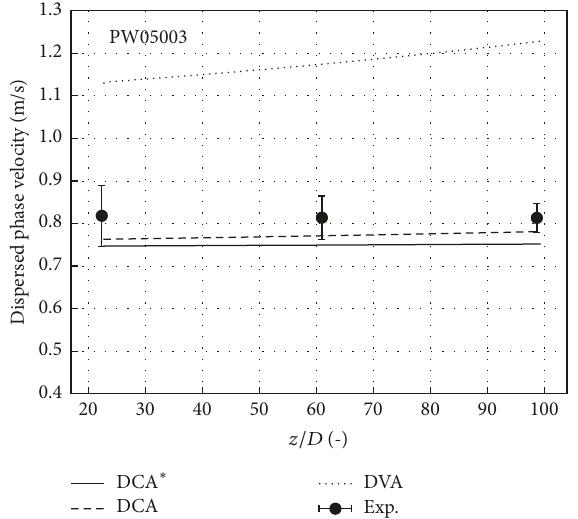
Figure 8: Comparison of dispersed phase velocity axial evolution for the different drag approaches.